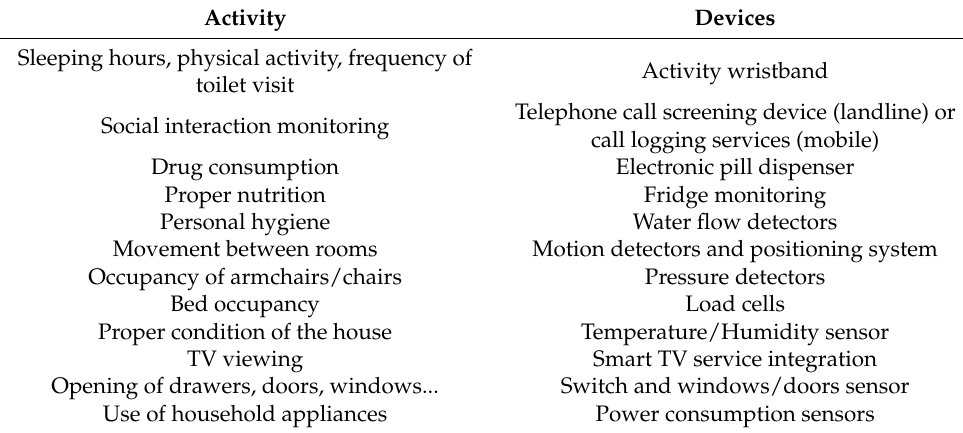
Table 2. Proposed monitoring activities and devices.